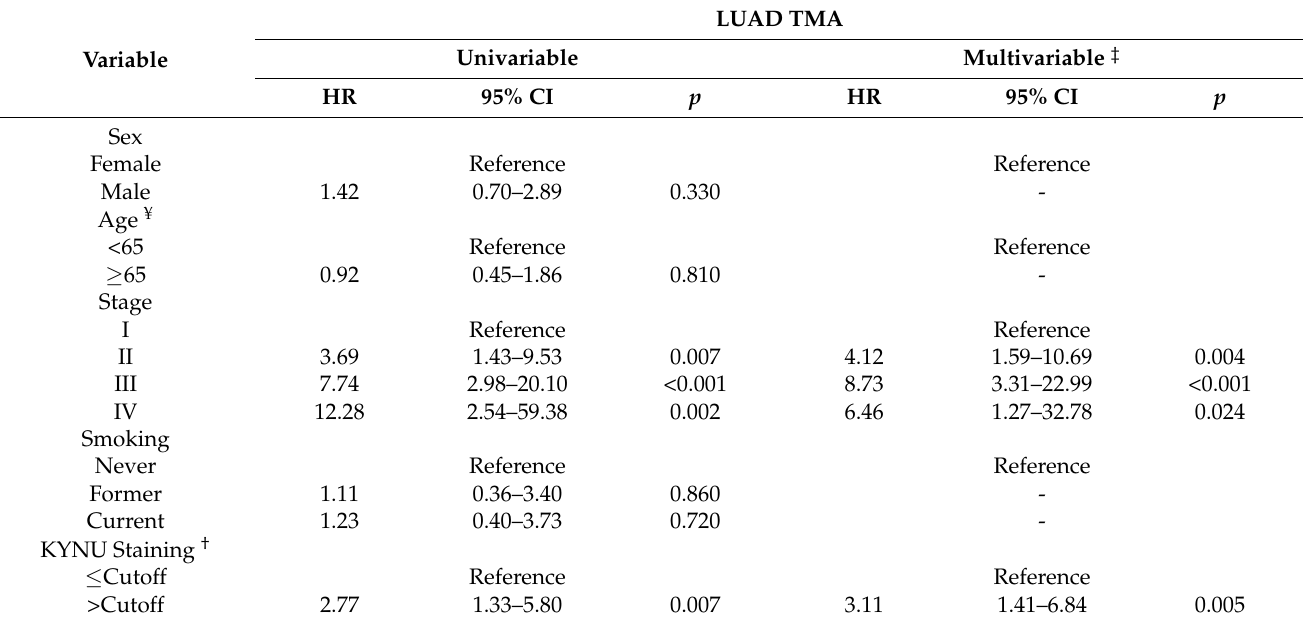
Table 1. Cox proportional hazard models for KYNU protein expression and overall survival in lung adenocarcinoma TMA.